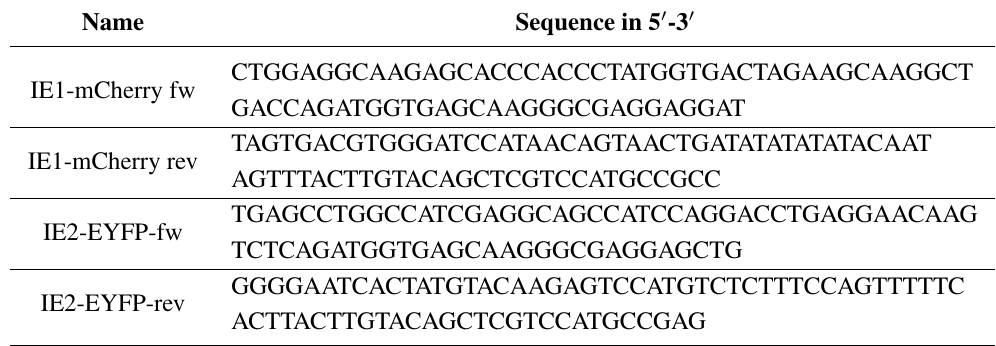
Table 1. Oligonucleotide primers for generation of recombinant human cytomegalovirus